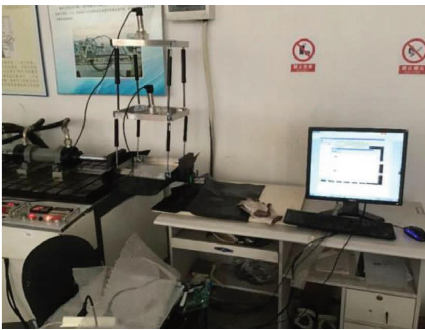
Figure 3: Schematic diagram of